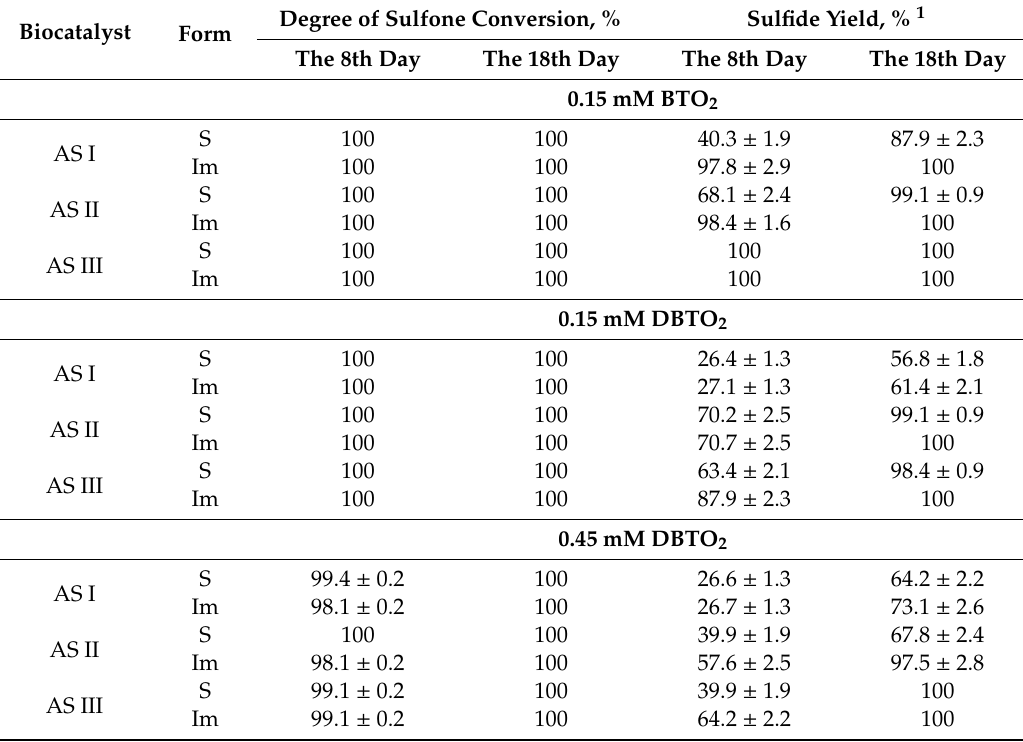
Table 1. Parameters of sulfones bioconversion to sulfide under the action of di ff erent samples of anaerobic sludge (AS) (S and Im: suspended and immobilized forms of AS, respectively).